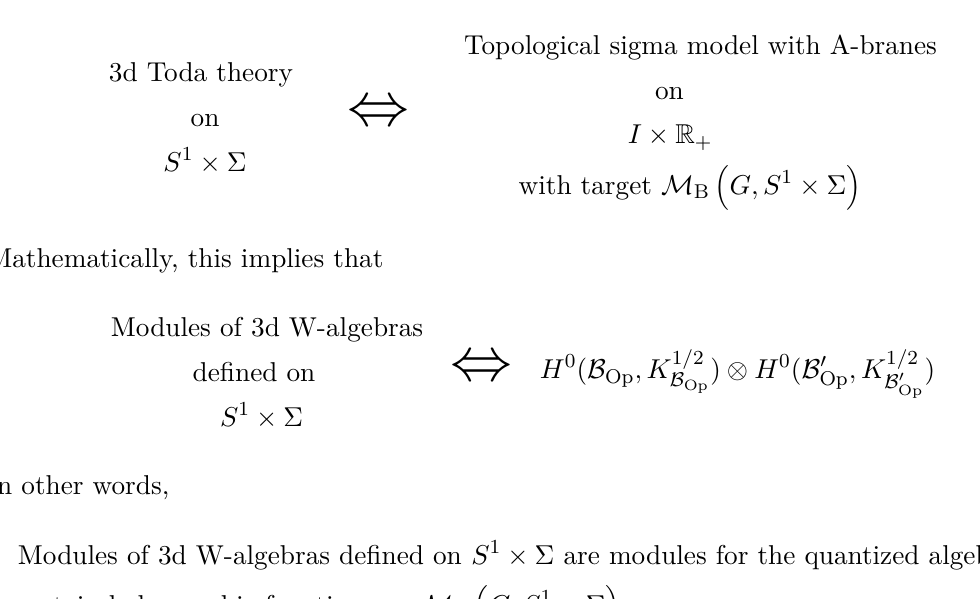
correspondence between the 3d Toda theory and the 2d A-twisted sigma model with target (cid:0) G, S 1 × Σ (cid:1) , i.e., we space M B